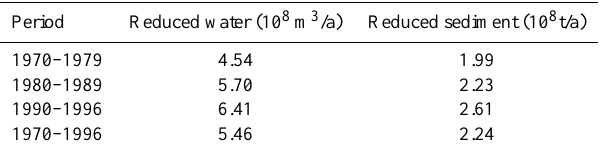
Table 9. The results of sediment discharge and streamflow reduc- tion through soil and water conservation measures in different peri- ods in the